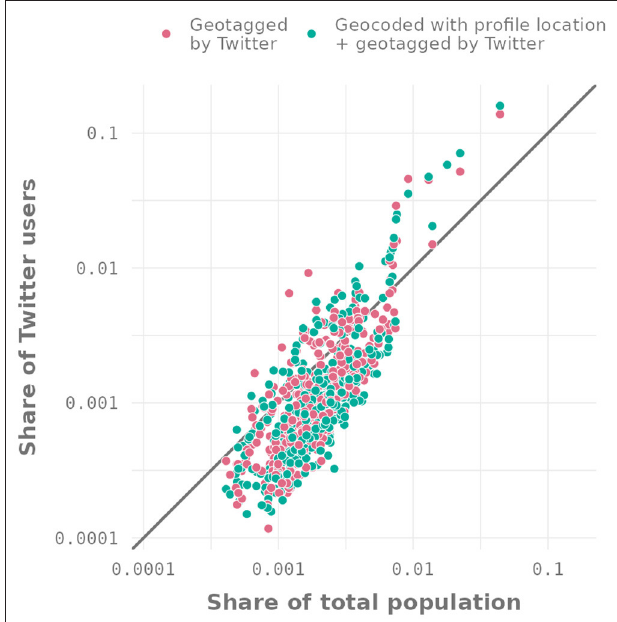
FIGURE 3 | Share of Twitter users geotagged by Twitter and geocoded with profile locations vs. share of the German population by NUTS-3